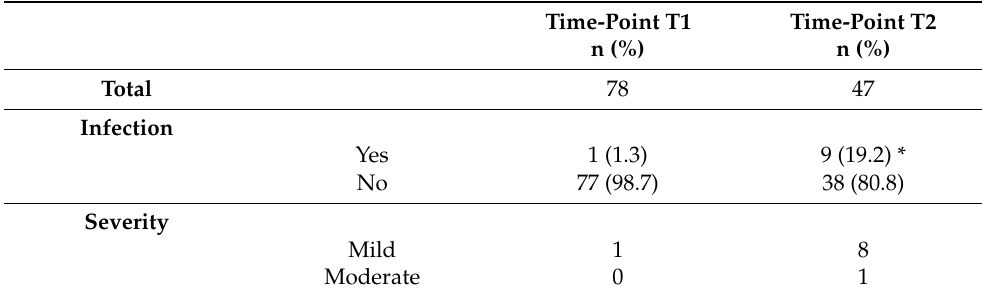
Table 4. Breakthrough infection in the rheumatoid arthritis patients at T1 and